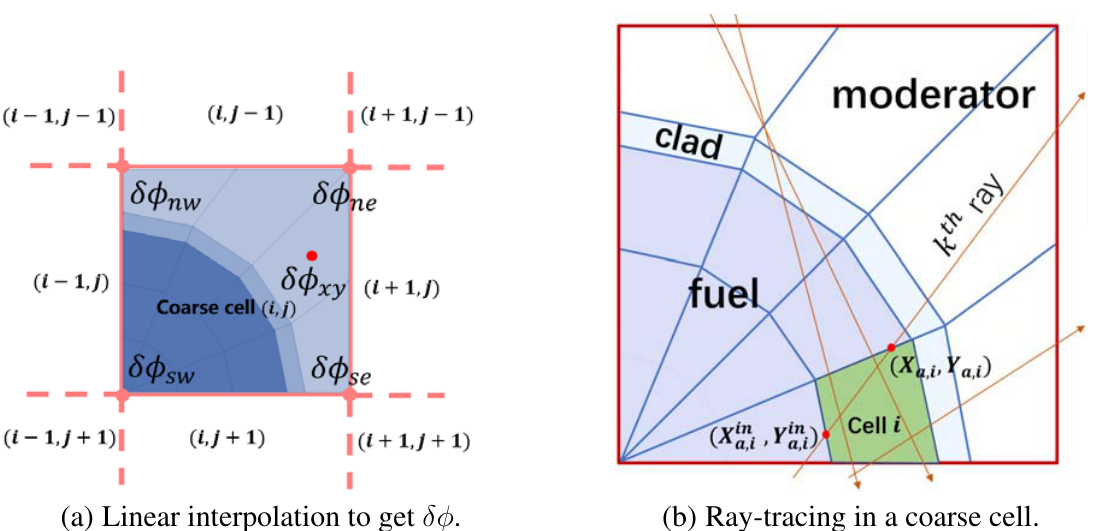
Figure 1: lpCMFD δφ interpolation and track-based centroids calculation